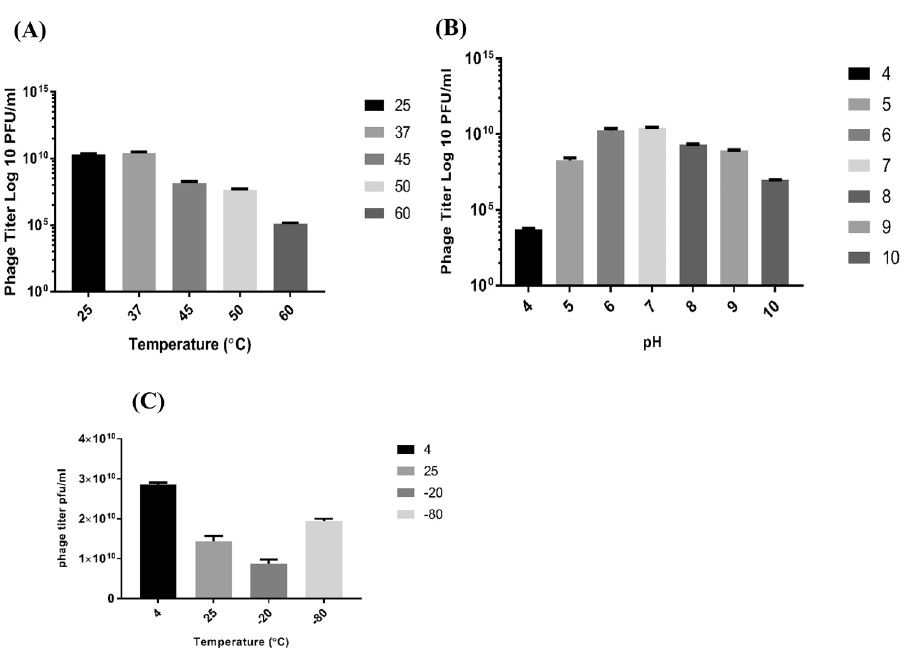
Figure 3. TSP bacteriophage stability assay. ( A ) Effect of different temperatures (25, 37, 45, 50 and 60 °C) on the stability of the TSP phage. ( B ) TSP phage was treated over a wide pH range (4, 5, 6, 7, 8, 9 and 10) for 1 h. ( C ) Storage stability of TSP phage at different temperatures (4, 25, − 20 and -80 °C) showed maximum survival ability at 4 °C. The experiment was performed three times, and phage titers are expressed as the mean ± standard